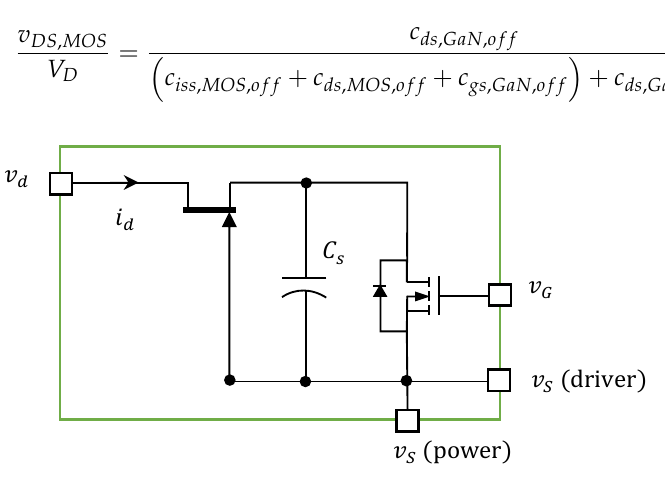
Figure 5. Type 1B—Modified cascode GaN HEMT power module. Figure 5. Type 1B — Modified cascode GaN HEMT power module. Table 2. Parameters of the Type 1B power module.